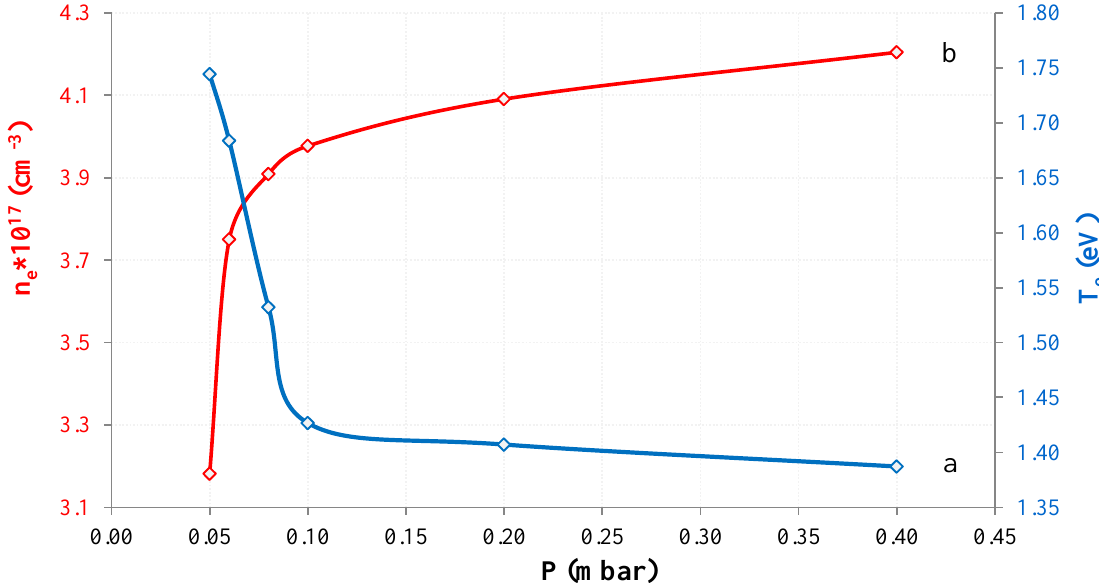
Fig. 7: The variation of (a) T